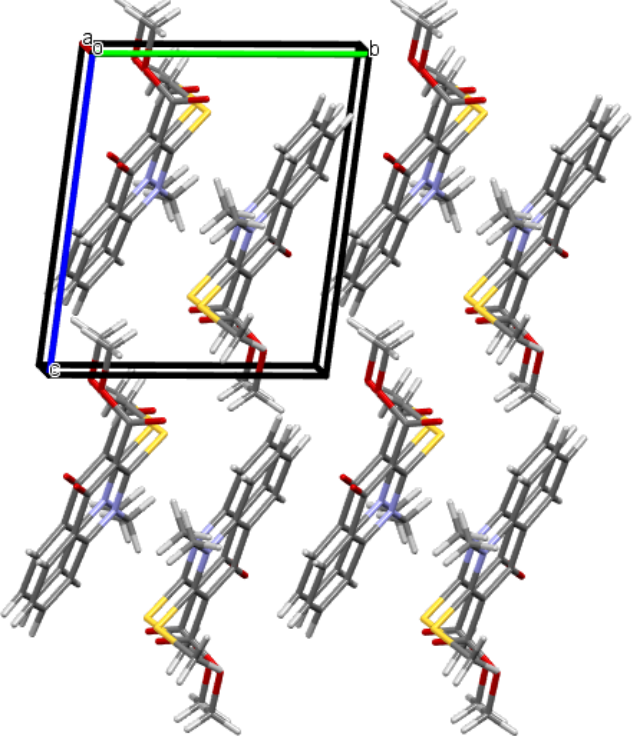
Figure 10. Packіng of molecules 5 in the crystal. The projectіon along the [1 0 0] crystallographіc dіrectіon is